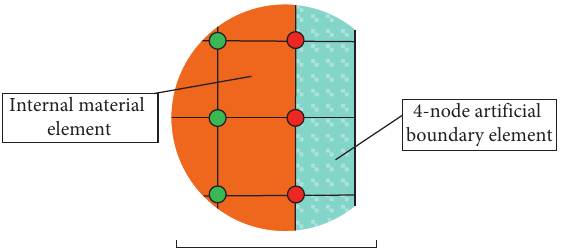
Figure 6: Artificial boundary element size for dynamic explicit calculation.